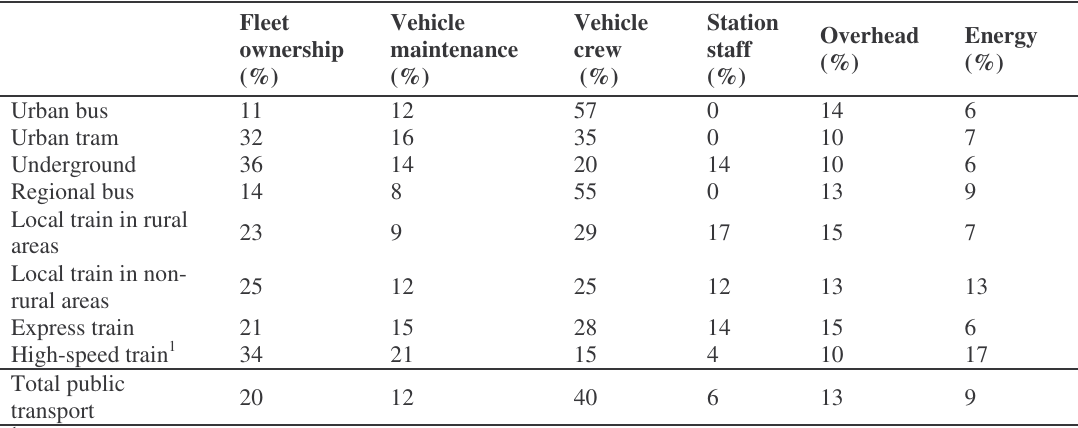
Table 2. Cost components of Dutch public transport in